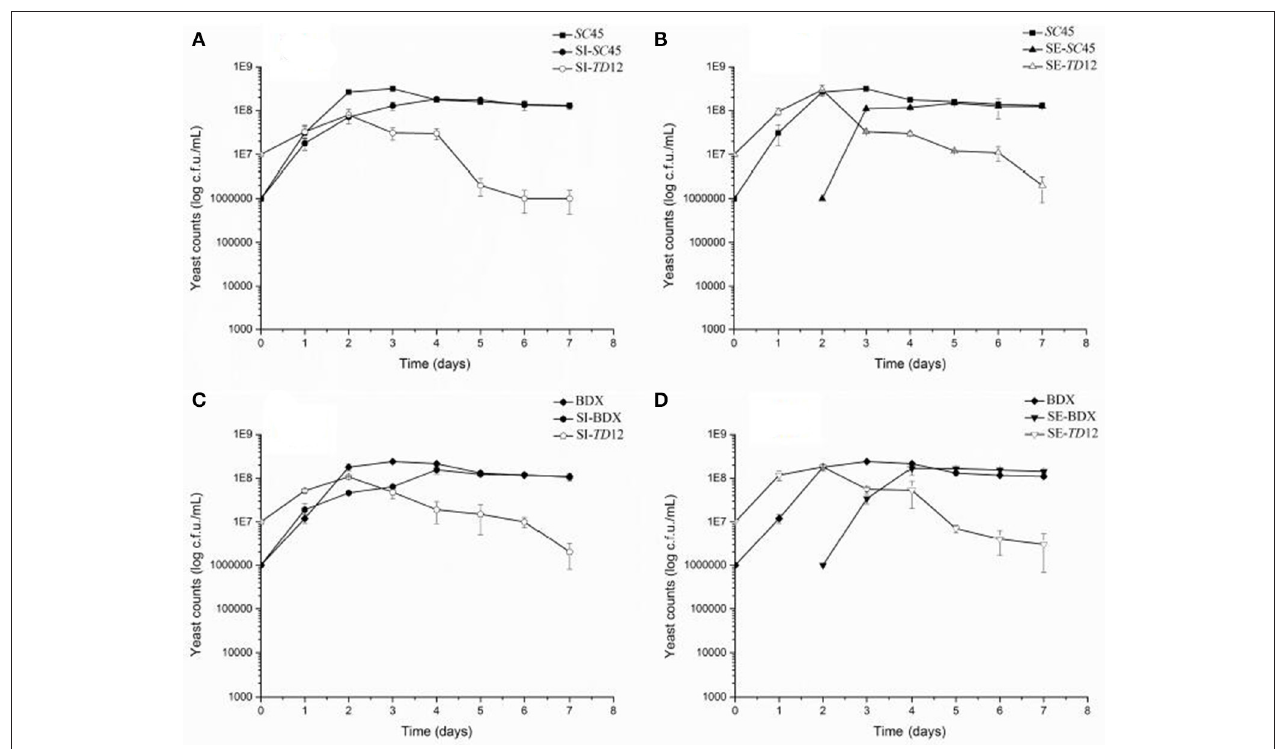
FIGURE 1 | Yeast population dynamics in different fermentations (A) SC 45 growth in pure fermentation ( SC45) and the growths of SC 45 and TD 12 in simultaneous fermentation (SI- SC 45 and SI- TD 12, respectively); (B) SC 45 growth in pure fermentation ( SC 45) and the growths of SC 45 and TD 12 in sequential fermentation (SE- SC 45 and SE- TD 12,respectively); (C) BDX growth in pure fermentation (BDX) and the growths of BDX and TD12 in simultaneous fermentation (SI-BDX and SI- TD 12, respectively); (D) BDX growth in pure fermentation (BDX) and the growths of BDX and TD 12 in sequential fermentation (SE-BDX and SE- TD 12, respectively). Error bars represent the standard